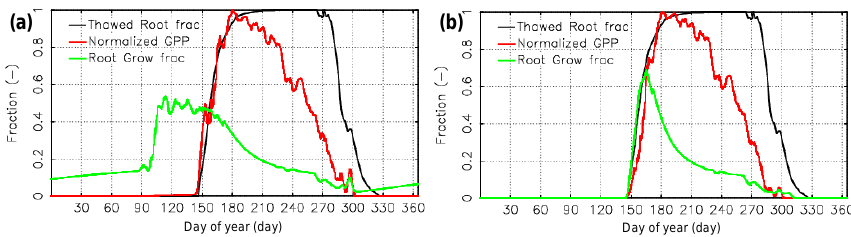
Figure 3. Root growth and GPP without (a) and with (b) the frozen soil constraint on growth. GPP is normalized to a maximum value of 1.0. The root growth fraction is relative to total plant